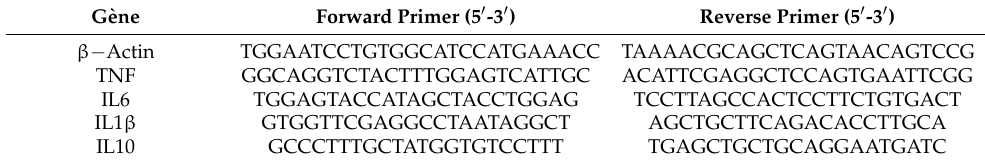
Table 1. RT-qPCR primers